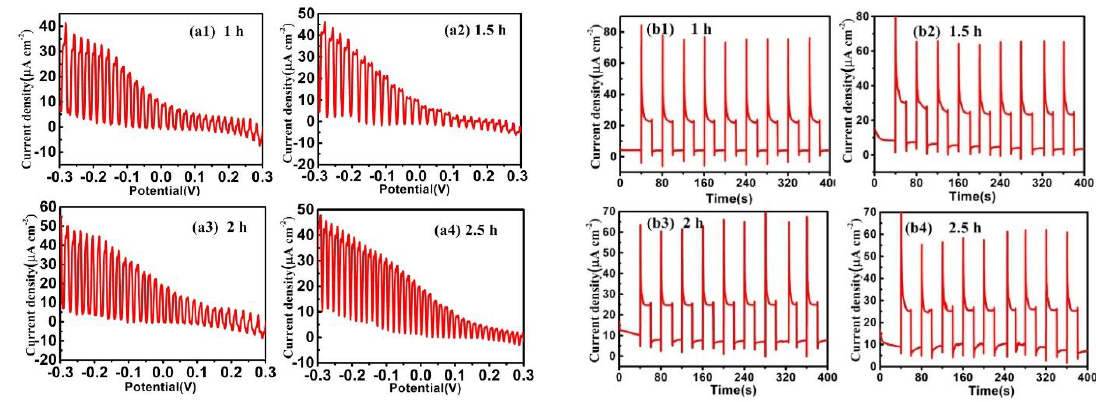
Figure 5. ( a1 – a4 ) Current-potential curves of CdTe thin films with deposition time of 1 h, 1.5 h, 2 h, and 2.5 h, respectively; ( b1 – b4 ) current–time curve of CdTe thin films with deposition time of 1 h, 1.5 h, 2 h, and 2.5 h, respectively.